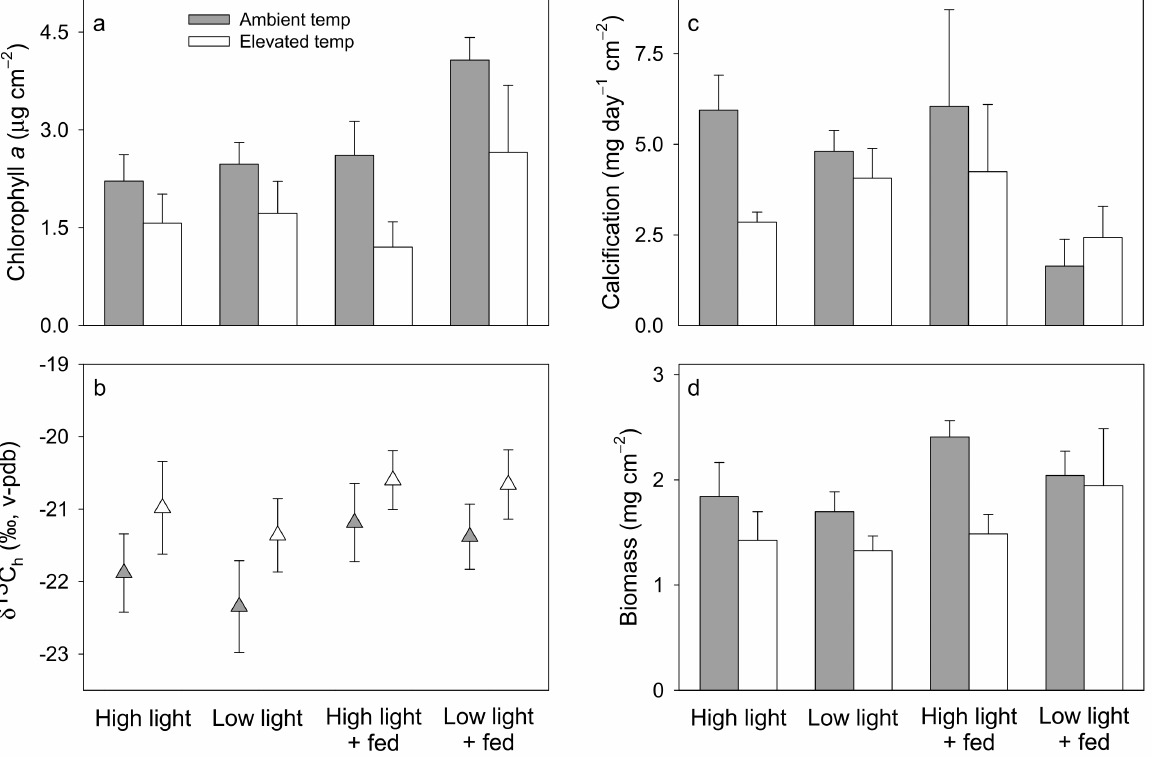
Figure 3. Pocillopora damicornis average ( ± 1 SE) ( a ) chlorophyll a , ( b ) δ 13 C h , ( c ) calcification, and ( d ) biomass, under ambient temperature (25 ◦ C, solid bars and symbols) or elevated temperature (30 ◦ C, open bars and symbols) within high light (300 µ mol photons m − 2 s − 1 , unfed), low light (150 µ mol photons m − 2 s − 1 , unfed), high light + fed (300 µ mol photons m − 2 s − 1 , fed), and low light + fed (150 µ mol photons m − 2 s − 1 , fed) treatments. N = 3–4 for all averages. Significant effects from corresponding ANOVAs indicated in Table